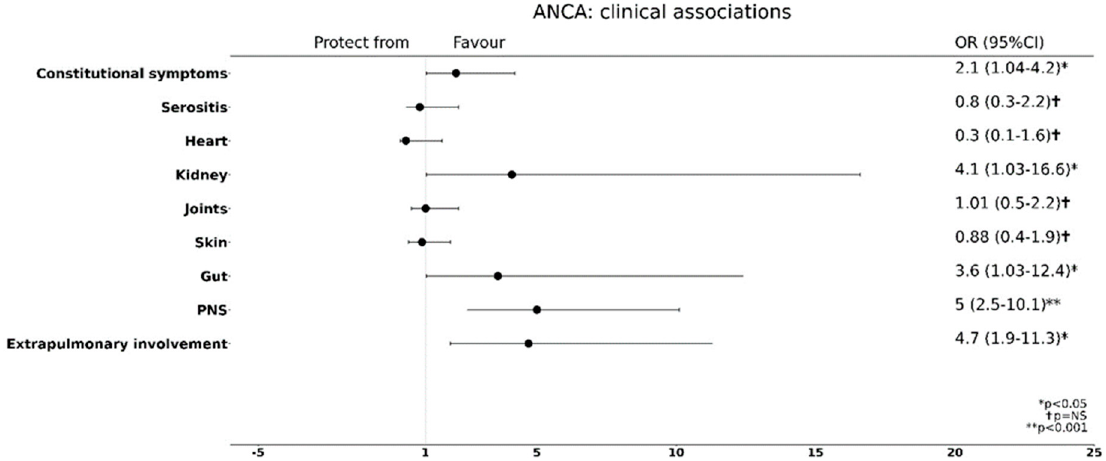
Figure 4. Prediction of organ involvement using ANCA as a predictor (Logistic Regression).